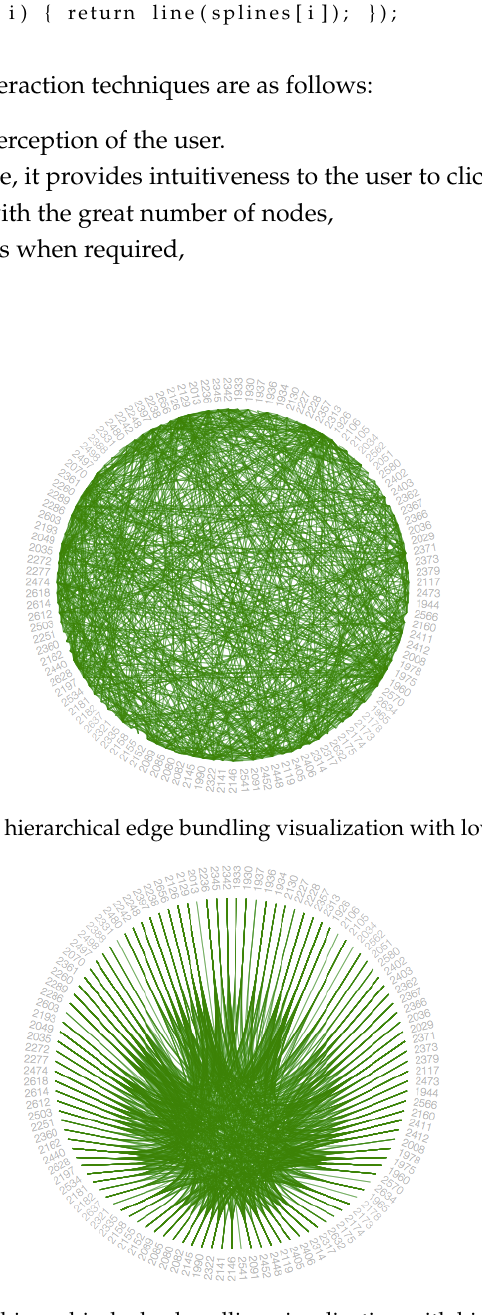
Figure 16. Represents hierarchical edge bundling visualization with high bundling